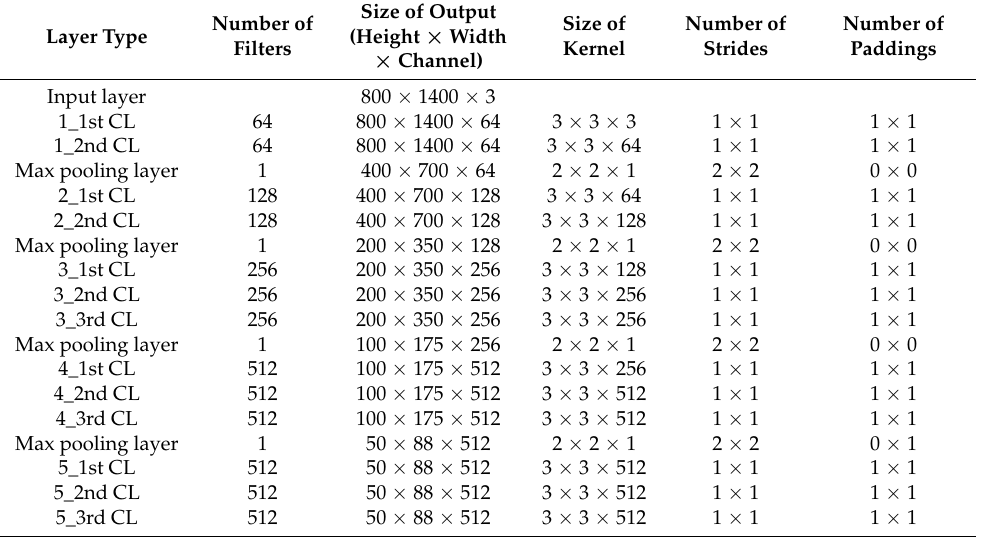
Figure 5. The structure of faster R-CNN. Table 2. Architecture of feature extractor in Figure 5 (All the convolutional layers (CLs) include ReLU layers).